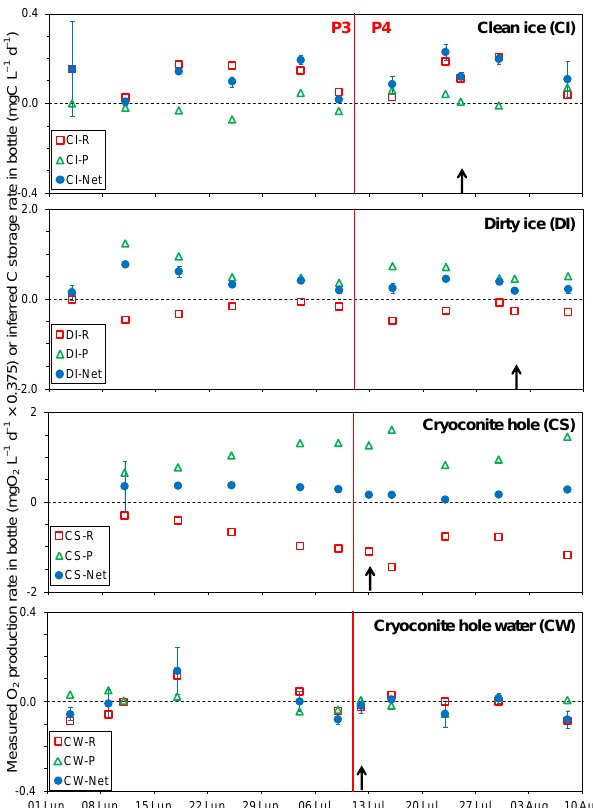
Figure 7. Seasonal variation in productivity as measured by O 2 pro- duction or inferred C storage in the BOD incubation experiments for (a) clean ice; (b) dirty ice; (c) cryoconite holes (cryoconite debris plus water); and (d) cryoconite hole water. Symbols are respiration (R; red squares) and net carbon storage (N; blue circles), both mea- sured directly, and inferred photosynthesis (P; green triangles) cal- culated by P = N–R. Note the different scales on the vertical axes. Arrows mark the times of 24-bottle single-sample-type variance ex- periments (see Fig. 10) and red lines mark the approximate change from period P3 to P4 (see